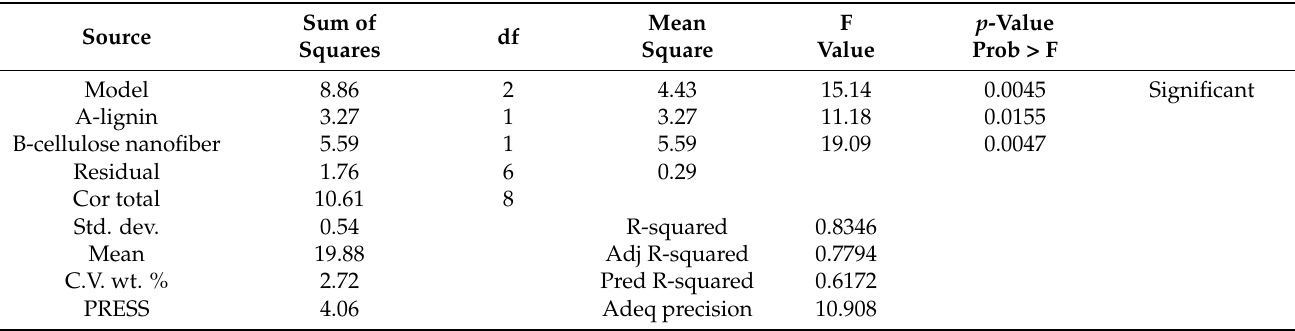
Table 3. ANOVA for response surface quadratic model for TS of lignin–cellulose nanofiber-filled thermoplastic starch composite film.